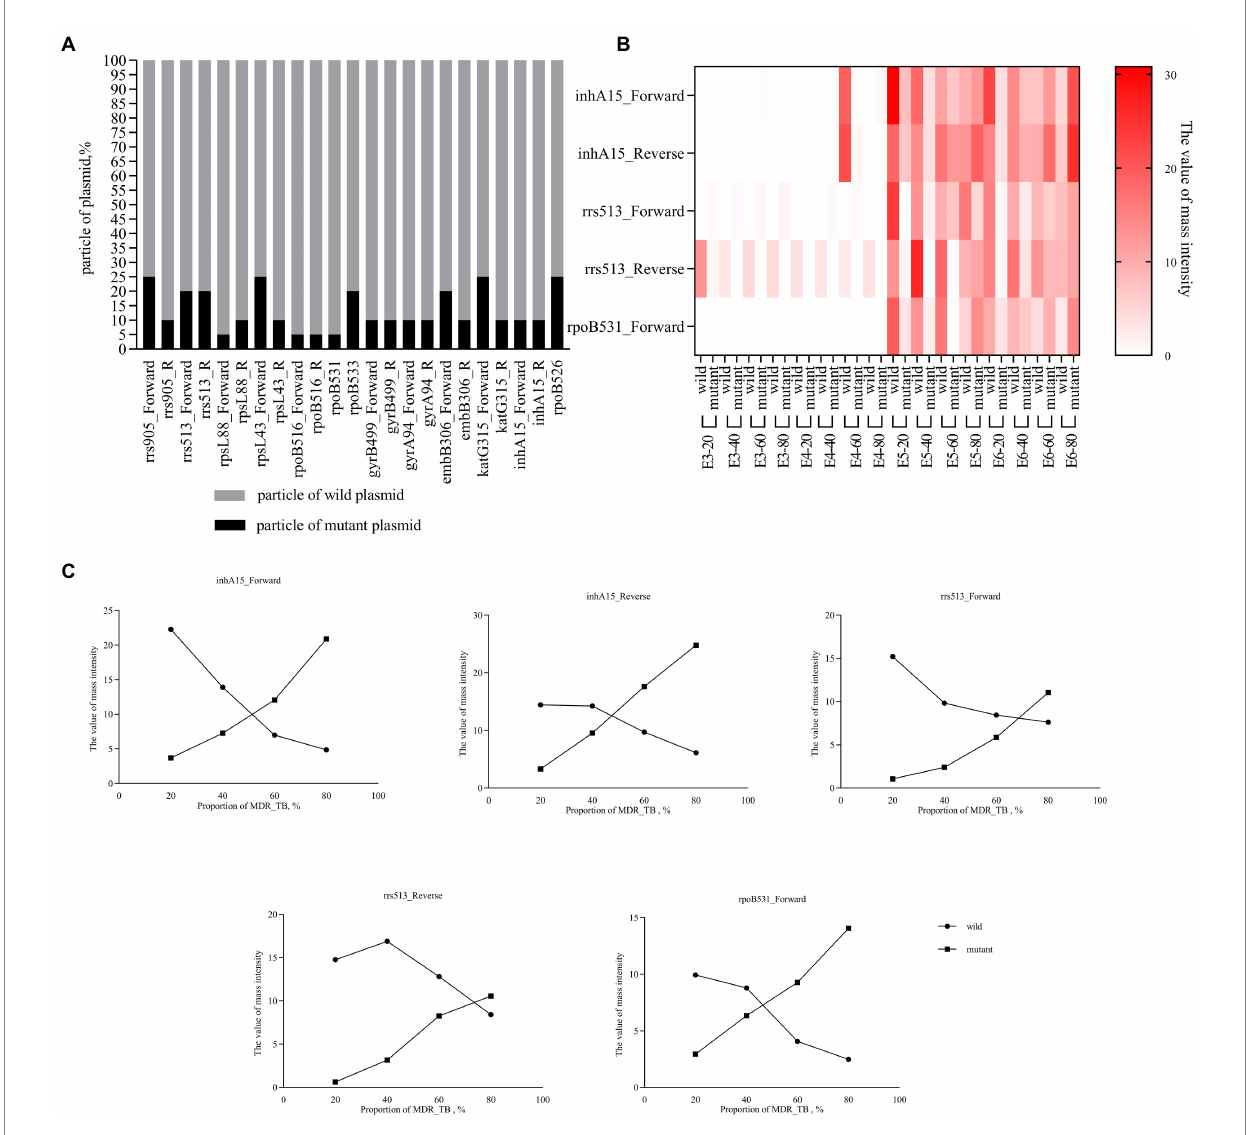
FIGURE 3 Detection capability of heteroresistance. (A) Percent stacked Chart of detection capability of heteroresistance by plasmid. The plasmid concentration is 10 7 copies/ μ L, mixed in different ratios, and the final volume is 100 μ L. (B) Heat map of detection capability of heteroresistance by bacteria. Clinically isolated MDR-TB was mixed with H37Rv at a ratio of 20–80%, the concentration was E3-E6 (10 3 –10 6 CFU/mL), and the final volume was 1 mL. For example, E3-20 refers to concentration of mixture was 10 3 CFU/mL (20% of Clinically isolated MDR-TB and 80% of H37Rv. (C) Line chart of mass intensity values in different proportions of MDR_TB. The concentration of the bacterial mixture in the Line chart of mass intensity was 10 5